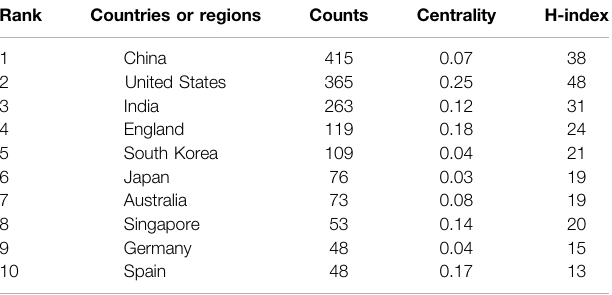
TABLE 1 | Top 10 countries or regions with publications on the application of the use of AI in the diagnosis of ophthalmic diseases from 2012 to 2021. Rank